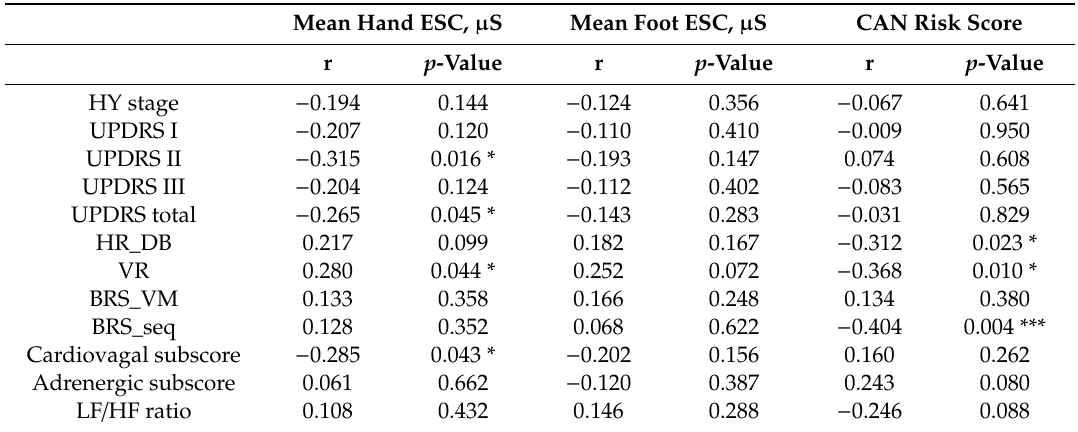
Table 5. Correlation analysis of electrochemical skin conductance in patients with Parkinson’s disease.